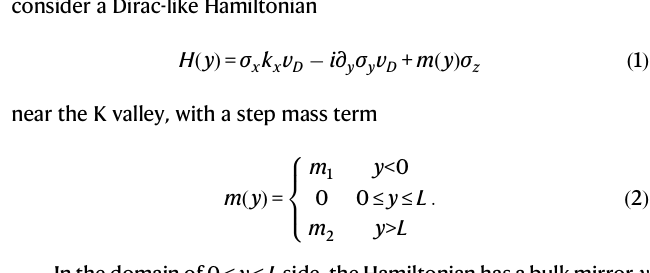
velocity fi elds of the eigenstates are zero at the mirror plane (black dashed line), while for the odd mode (blue band), the velocity fi eld of theeigenstatesisthemaximumatthemirrorplane.Thesemodescross at the K point.